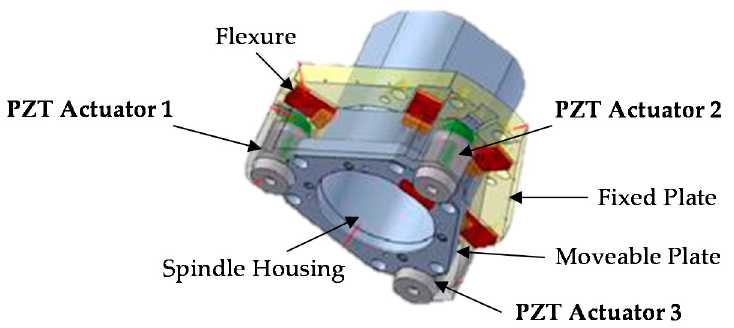
Figure 2. 3D CAD Module overview.